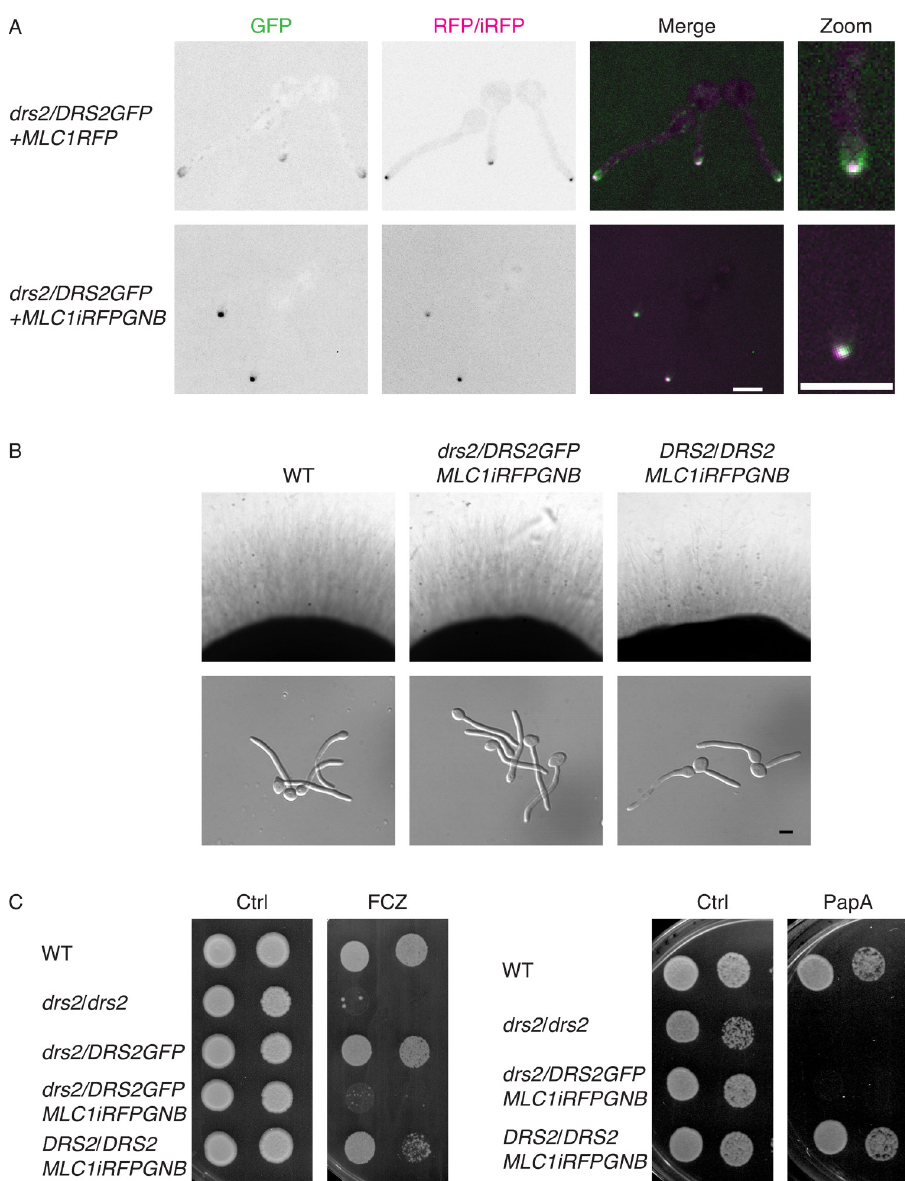
Fig 12. Stabilization of Drs2 at the Spitzenko¨rper alters growth on papuamide A and fluconazole. A). Synthetic physical interaction (SPI) between Drs2 and Mlc1 stabilizes Drs2 at the Spitzenko¨rper. Representative images (central z-sections) of cells expressing Drs2-GFP, as a sole copy of Drs2, with either Mlc1RFP (PY4928) or Mlc1-iRFP-GNB (PY5885) are shown; iRFP stands for near- i nfra r ed f luorescent p rotein and GNB for GFP nanobody. Right panels are enlargement of merge images. B) Stabilization of Drs2 at the SPK does not alter invasive filamentous growth. The indicated strains, WT (PY4861), drs2/DRS2GFP MLC1-iRFP-GNB (PY5885) and DRS2/DRS2 MLC1-iRFP-GNB (PY5385) were grown on agar-containing serum media and images were taken after 6 days (top panels) or grown in the presence of serum for 90 min (bottom panels). The percent of filamentous cells was 85–86% for the wild-type, drs2/ DRSGFP MLC1-iRFP-GNB and DRS2/DRS2 MLC1-iRFP-GNB strains; 2 experiments, n ~ 100 cells. C) Stabilization of Drs2 at the SPK alters growth on fluconazole and papuamide A. Serial dilutions of WT (PY4861), drs2/drs2 (PY3375), drs2/DRS2GFP (PY4665), drs2/DRS2GFP MLC1-iRFP-GNB (PY5885) and DRS2/DRS2 MLC1-iRFP-GNB (PY5385) strains spotted on YEPD media (Ctrl) containing either 2.5 μ g/ml fluconazole (FCZ) or 2 μ g/ml papuamide A (PapA) and images were taken after 2